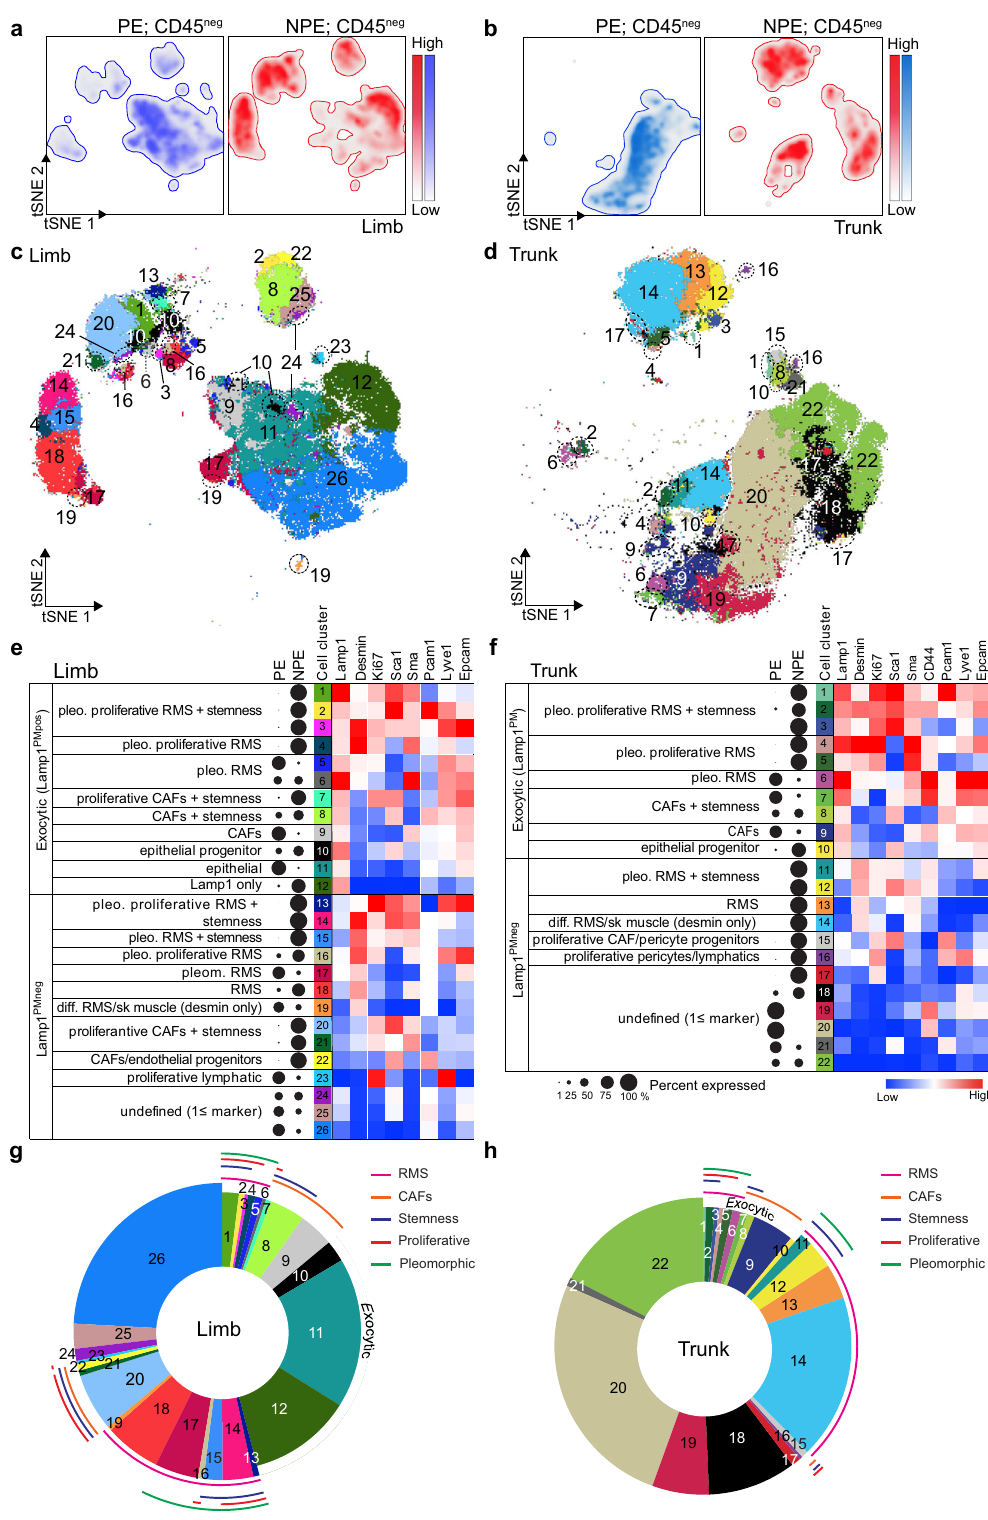
Fig. 5 Lamp1 PMpos cells are enriched in exocytic undifferentiated NPE RMS. a , b tSNE graphs showing density and distribution of CD45 neg cells from limb ( a ) and trunk ( b ) RMS of PE (blue) and NPE (red) mice. c , d tSNE of single-cell analysis of limb ( c ) and trunk ( d ) representation of the distinct cell clusters identi fi ed in RMS (numbered and colored) with the markers used with CD45 neg cells from PE and NPE mice. e , f Annotated limb ( e ) and trunk ( f ) RMS CD45 neg exocytic Lamp1 PMpos and Lamp1 PMneg cell populations from PE and NPE mice. Bubble map indicates the percentages of cells from PE and NPE contributing to a cell cluster. Heatmap shows the signal intensity of expression of the different markers used. g , h Pie graph of CD45 neg cells from limb ( g ) and trunk ( h ) PE and NPE RMS showing the percentage of each cell cluster (numbered and colored matched).